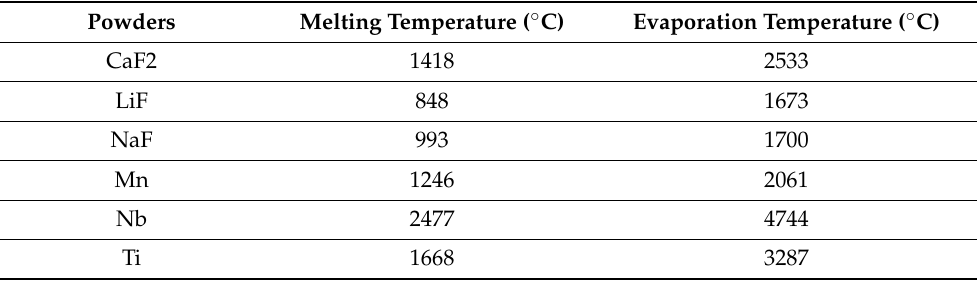
Table 2. Powders, melting and evaporation